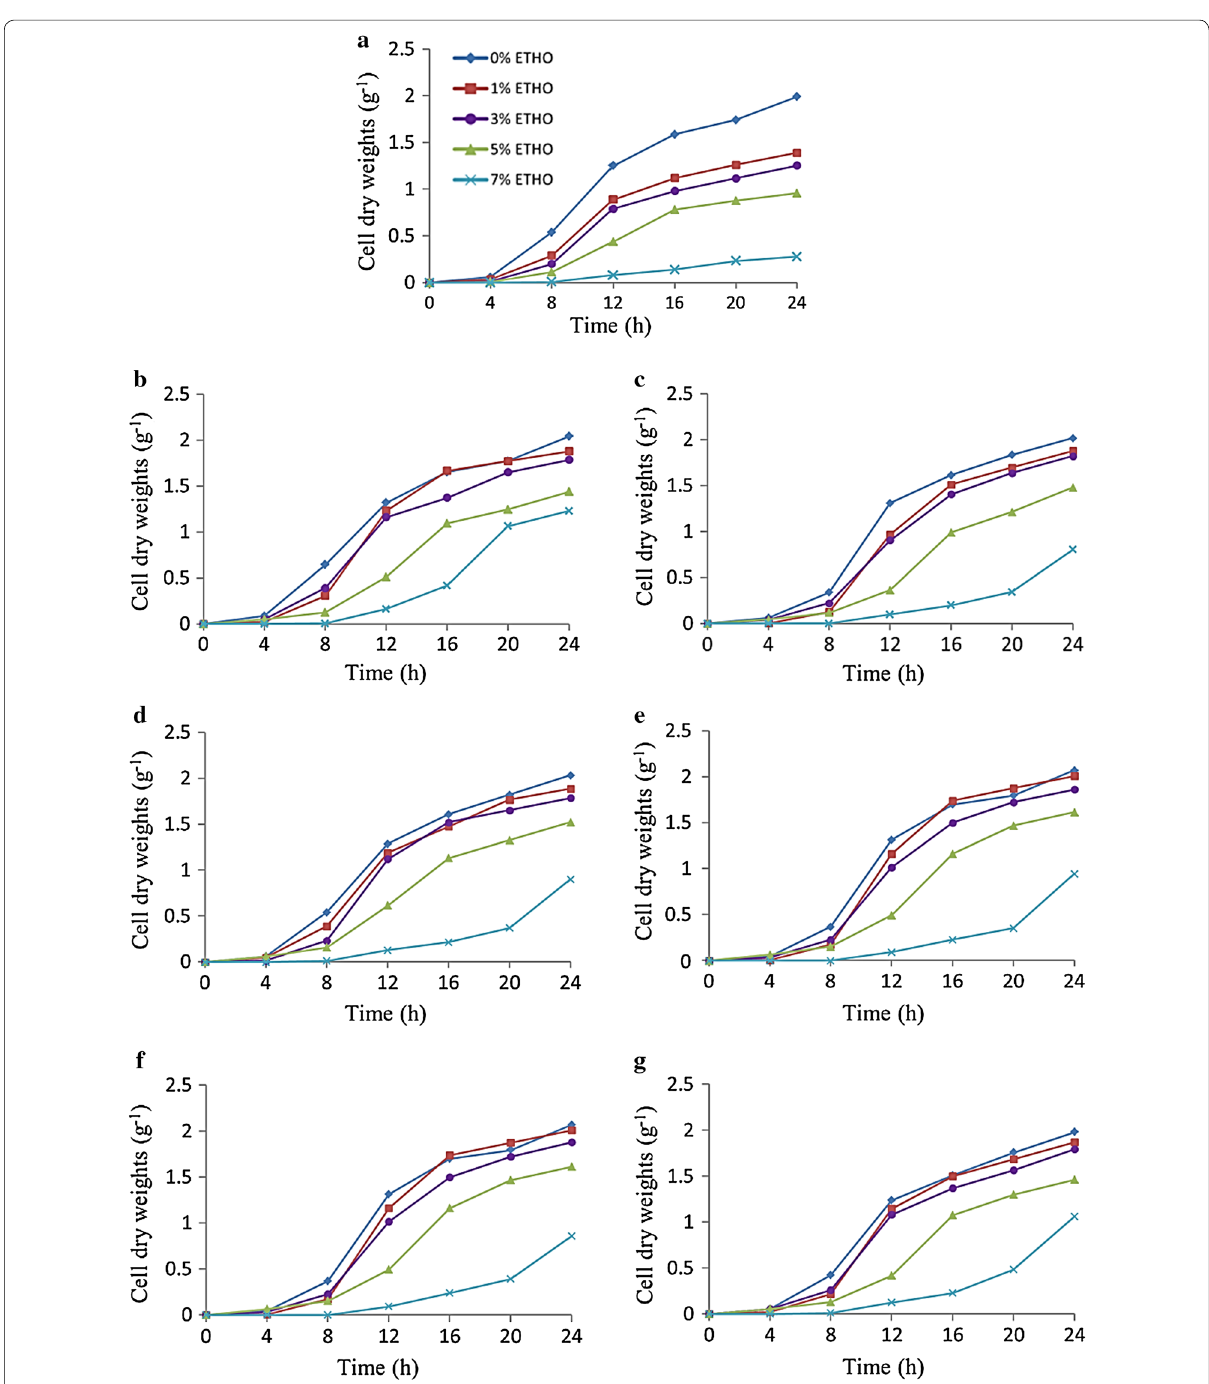
Fig. 4 a Growth curve for the R‑control strain and b – g growth curves for the best mutant strains (R‑M20C1, R‑M16C4, R‑M4C1, R‑M12C4, R‑M18C4 and R‑M5C1) obtained by the Ep‑PCR reaction by using 3% MnCl 2 concentration, respectively. These strains were inoculated into the YPDT medium at different levels of ethanol concentrations ( ) 0% ETHO, ( ) 1% ETHO, ( ) 3% ETHO, ( ) 5% ETHO and ( ) 7%